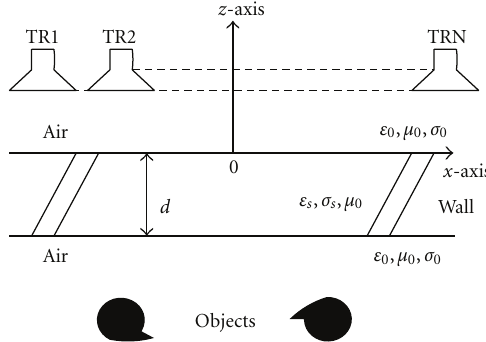
Figure 1: Geometry for multiobject